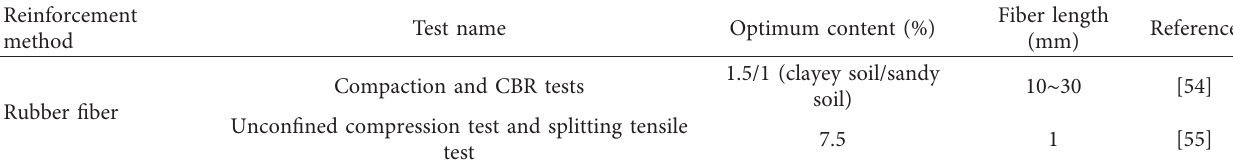
Table 2: Summary of reinforcing soil with rubber